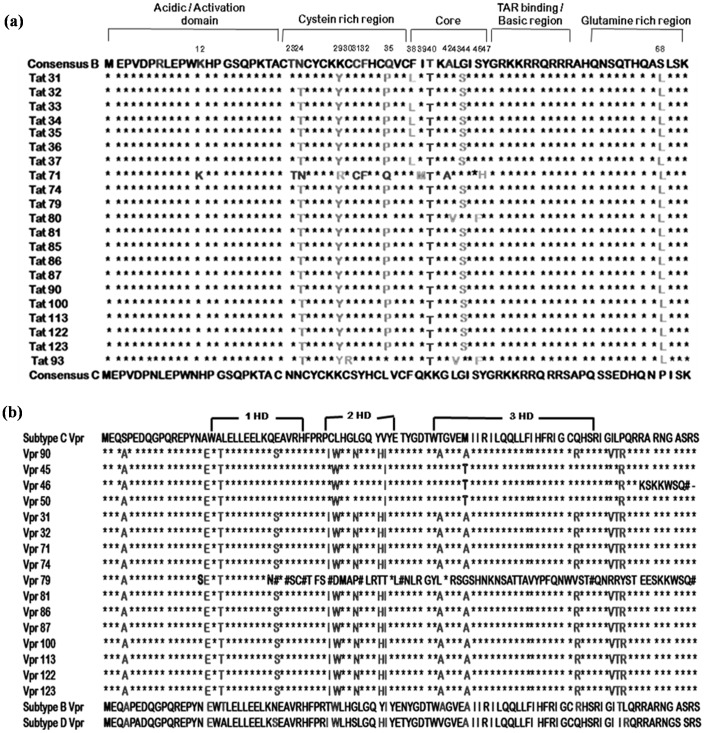
Amino acid sequence alignment of Tat exon 1 and Vpr sequences of HIV-1 infected patients.(a) Tat exon 1 sequences were aligned against HIV-1 subtype B and C consensus sequences by Clustal W. In the sequence alignment, amino acids identical to Consensus C are denoted by stars (*), amino acids identical to Consensus B, mutations conserved in all test sequences and unique mutations are shown alphabetically. The positions of the mutated amino acids are indicated above the alignment. (b) Amino acid sequences of Vpr variants from HIV-1 infected patients were aligned against HIV-1 subtype B, C and D reference sequences by Clustal W. In the sequence alignment, amino acids identical to Consensus C are denoted by stars (*). Amino acids identical to Consensus B & D, mutations common in test sequences and unique mutations are shown in alphabets.